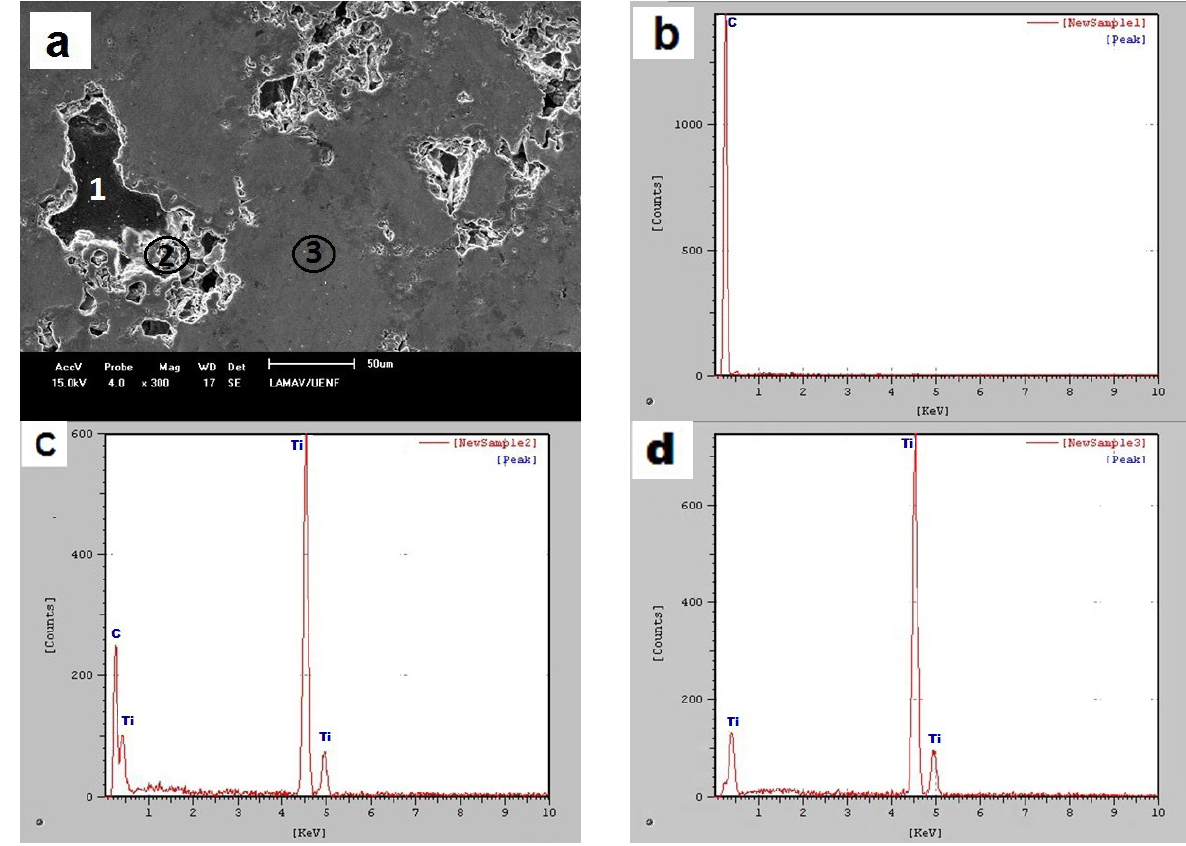
Figure 2 - Micrograph of the polished surface of the composite Ti-5% diamond with marking points analyzed by EDS ( a ). Magnification 300x. The corresponding spectra represent the chemical composition of points 1 ( b ), 2 ( c ) and 3 ( d ).